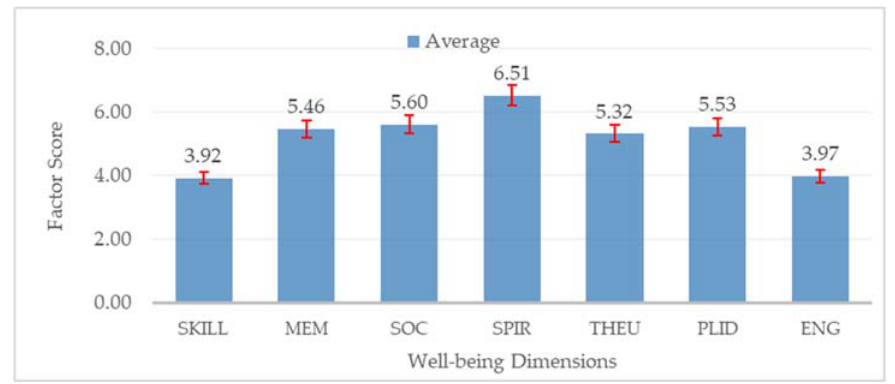
Figure 11. Overall factor scores average and standard deviation for Gili Matra Islands. SKILL: Skill and challenge dimension; MEM: Memory/Transformative value; SOC: Social bonds; SPIR: Spiritual value; THEU: Therapeutic value; PLID: Place identity; ENG: Engagement and interaction with nature.